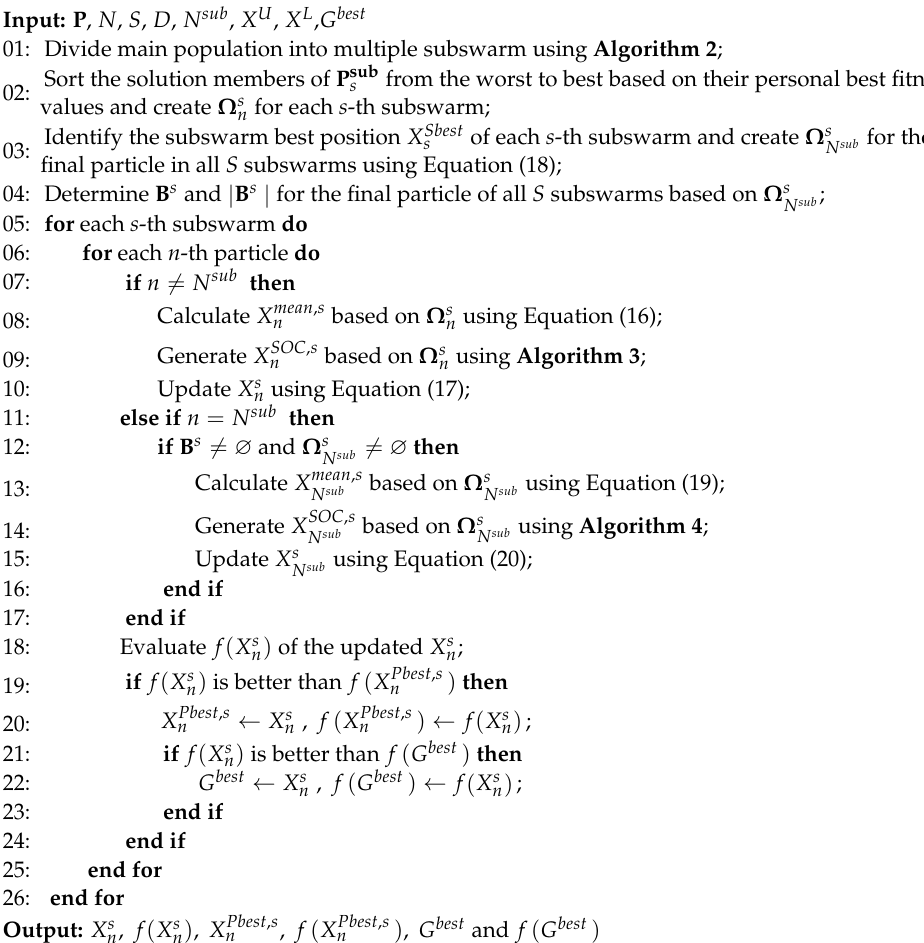
Algorithm 5. Pseudocode of primary learning phase for